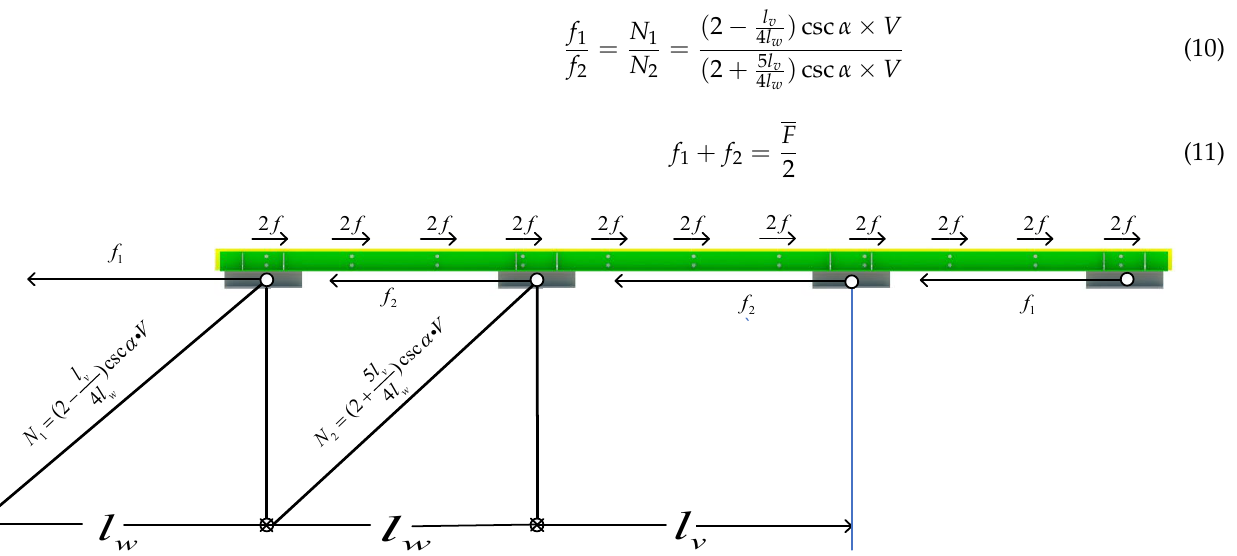
Figure 19. The axial force analysis of the web member of friction energy dissipation composite chord under horizontal force.